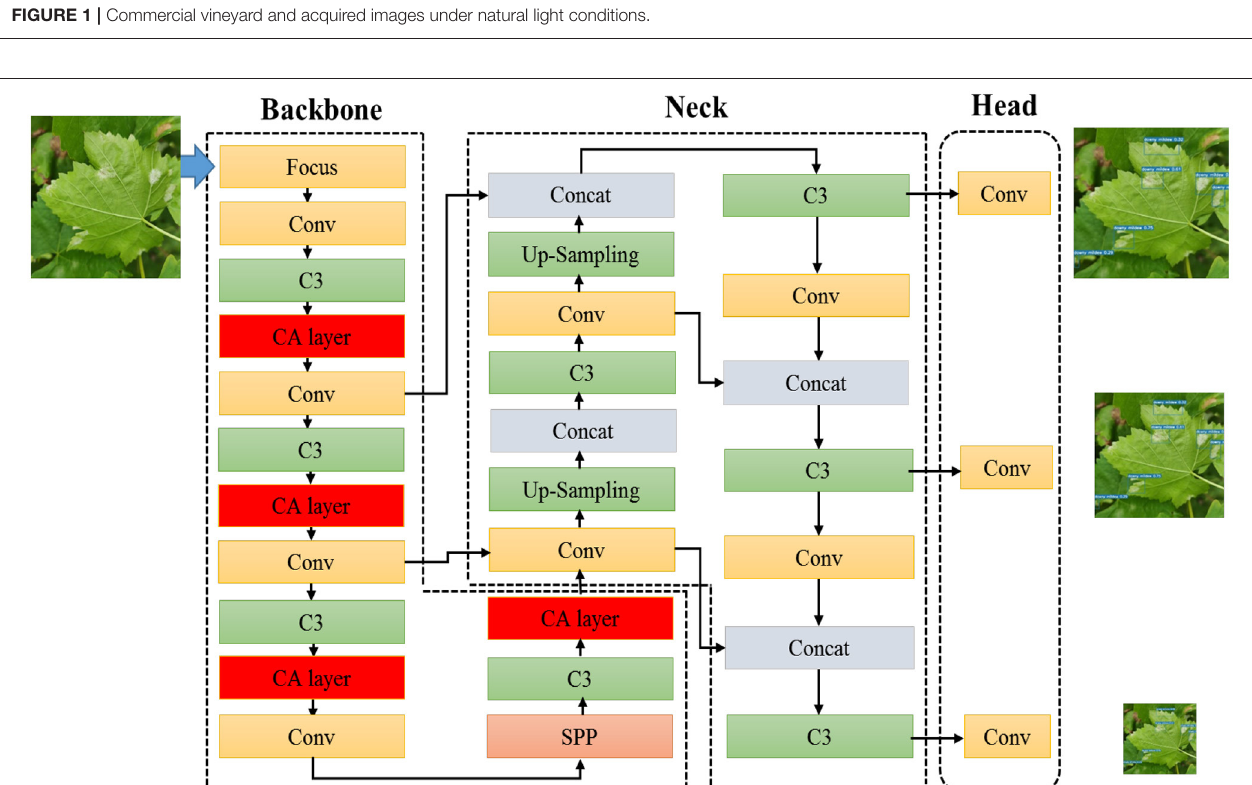
FIGURE 2 | The architecture of the proposed YOLOv5-CA based GDM